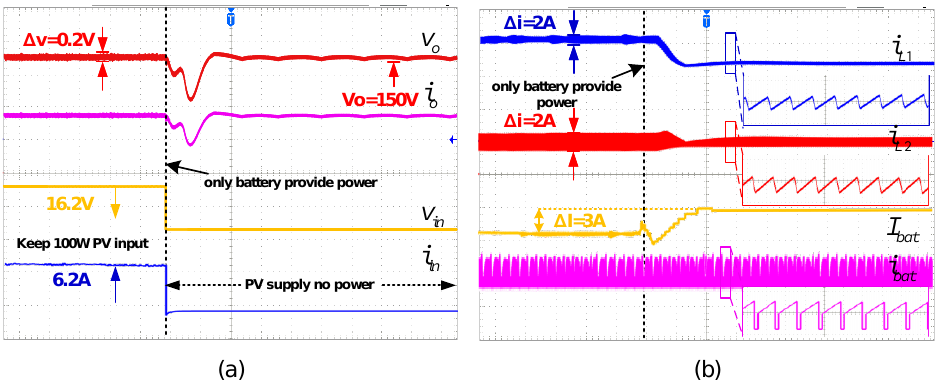
Figure 12. Waveforms of ( a ) v in , i in , v o , and i o , and ( b ) i bat , I bat , v GS 1 , and v GS 2 when only the battery provides